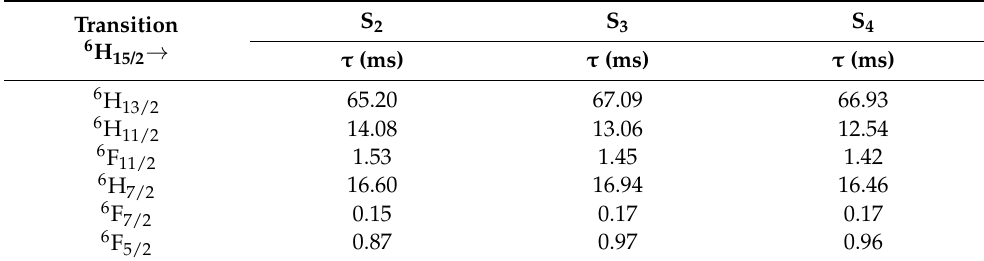
Table 4. Calculated lifetimes ( τ , ms) of glass samples.